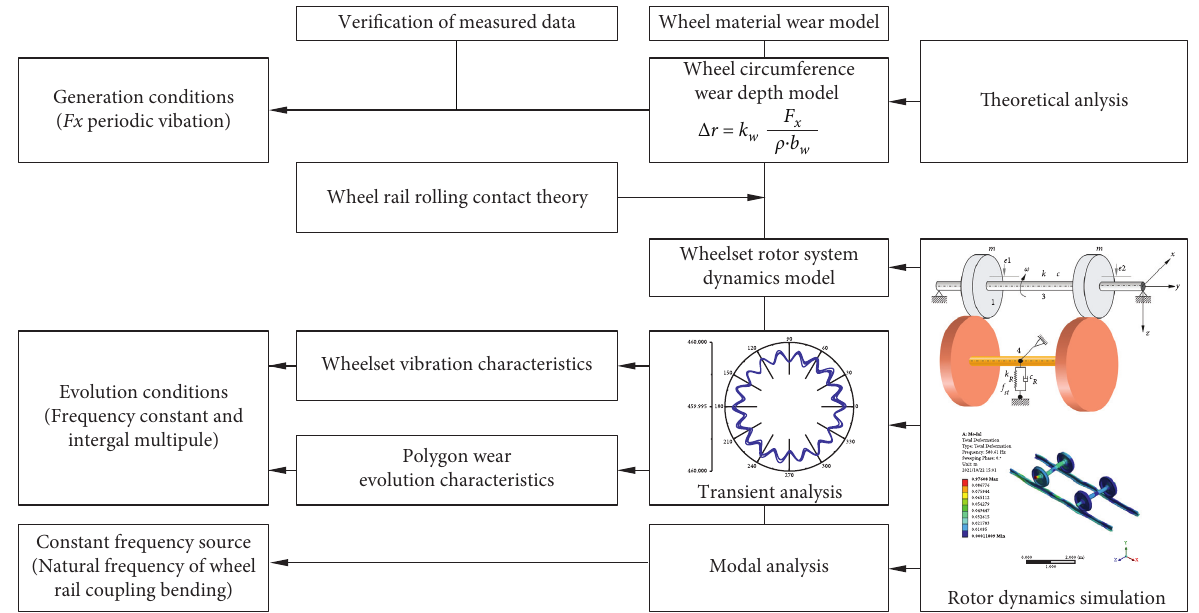
Figure 1: Research process of the generation and evolution conditions of wheel polygonal